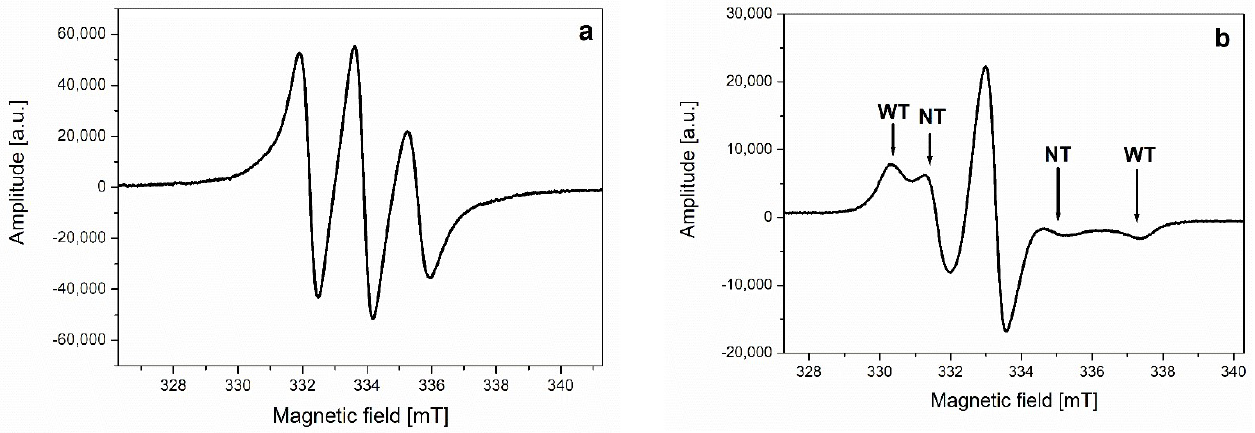
Figure 5. ESR spectra of spin probes with yeast cells at 240 K: ( a ) TEMPO with the narrow triplet; ( b ) TEMPOL with wide (WT) and narrow (NT) ( b ) TEMPOL with wide (WT) and narrow (NT) triplets.